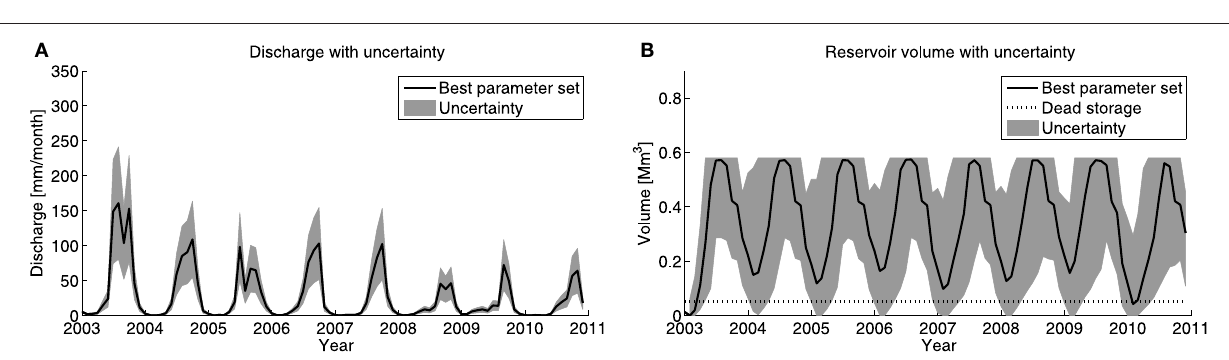
FIGURE 6 | (A) Simulated discharge using the best parameter set, including uncertainty bands, and (B) reservoir volume using best parameter set, including uncertainty bands. The uncertainty bands are based on input data